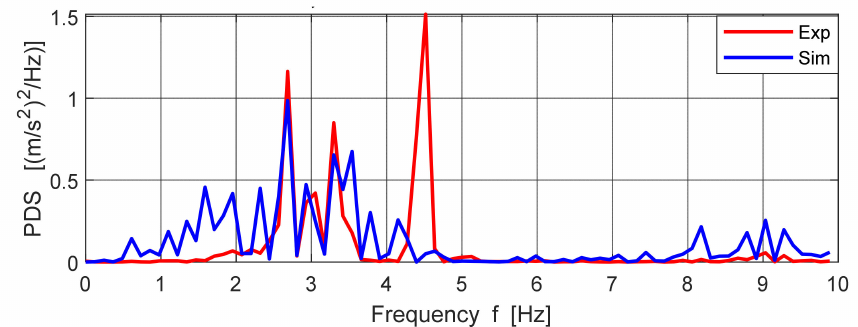
Figure 31. PSD of vertical accelerations in vehicle CG, 0–10